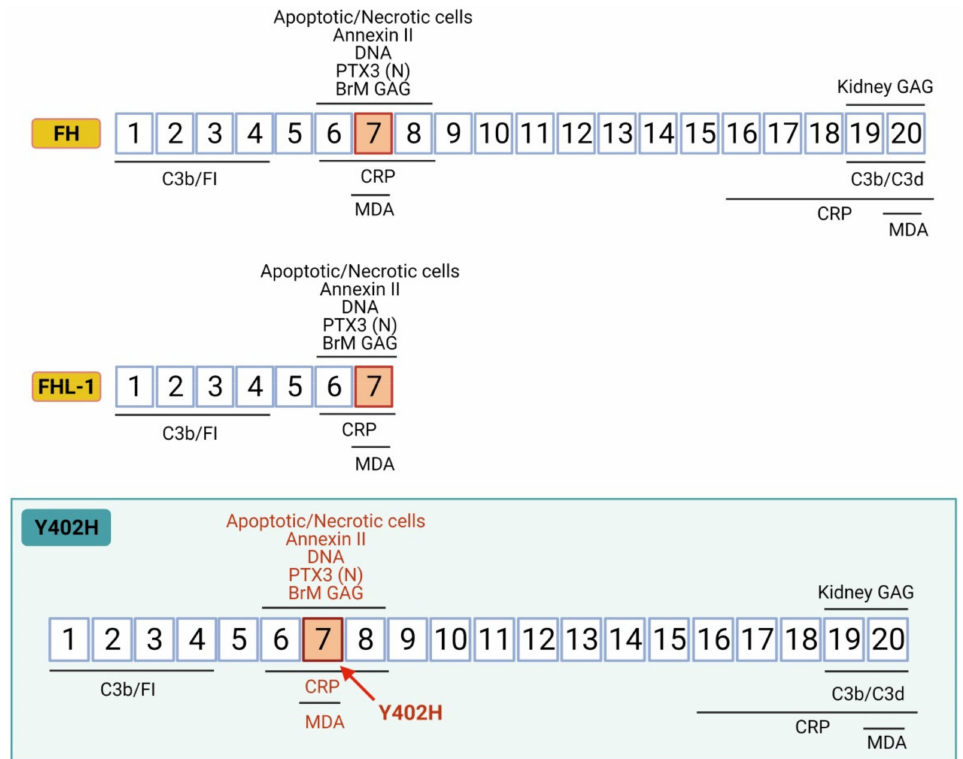
Figure 3. Complement factor H structure. The CFH gene encodes a single chain of 20 complement control protein domains (CCPs). CCPs 1–4 and CCPs 19–20 are C3b binding regions; CCPs 6–8 are glycosaminoglycan (GAG)-binding regions in BrM; CCPs 19–20 are GAG-binding regions in kidney; CCPs 6–8 and CCPs 16–20 are C-reactive protein (CRP) binding regions and CCPs 7 and CCP 20 are malonaldehyde (MDA) binding regions. Y402H variant implies a tyrosine to histidine substitution at amino acid 402 in CCP7, the domain involved in binding to GAGs-BrM, CRP, MDA, oxLDL, and apoptotic cells. FHL-1 is a naturally occurring truncated form of FH that predominates in BrM and encodes the first seven FH CCPs. Therefore, FHL-1 maintains regulatory function and binding to CRP, MDA and BrM-GAG, and it is also affected by the Y402H polymorphism that lies on CCP7